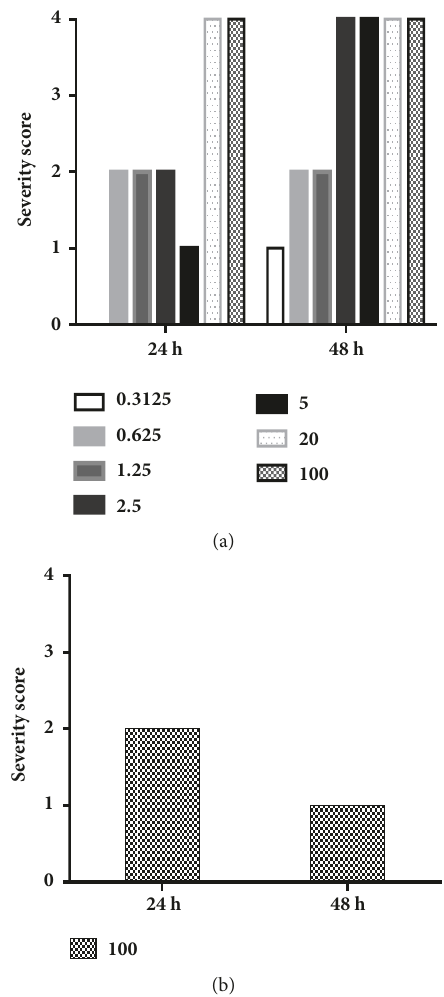
Figure 1: Severity scores for fractions derived from E. ivorense methanol leaf extracts tested against somules. Scores associated with (a) the acetone fraction and (b) the methanol extract. Note that for (b), activity was only detected at 100 𝜇